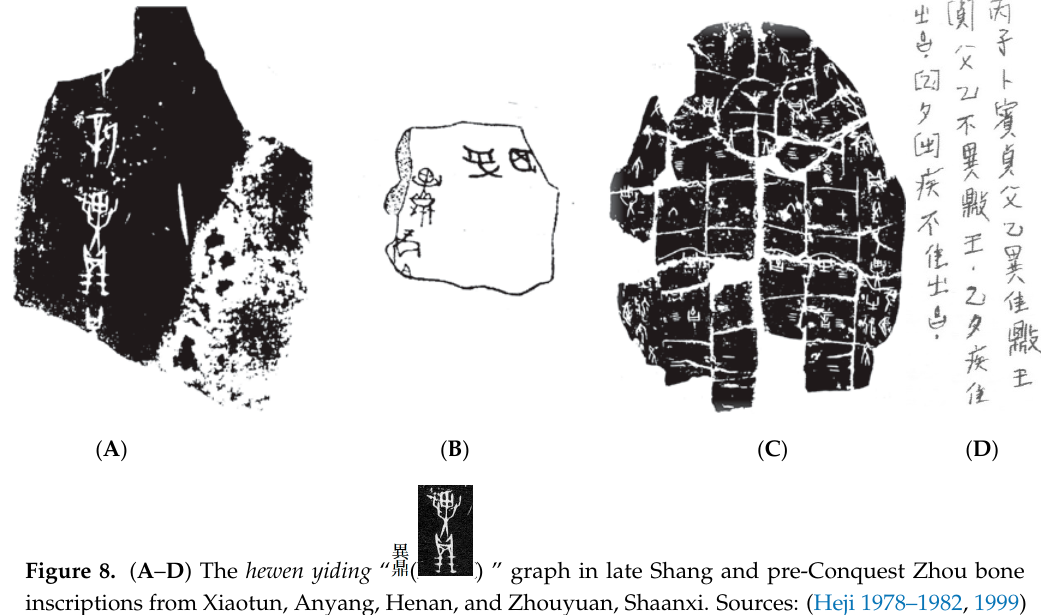
Figure 1. Masked semi-human figures with arms raised. ( A ) Yi 異 graph; ( B ) Displayed yi image, Childs-Johnson 2008 p. 8: Figure 8C, p. 58 (right). ( A ) […] 卜新 ( 異鼎 )), 祝 The bone was cracked: Childs-Johnson 2008, p. 8: Figure 8C, p. 58 (right). ( A ) [ . . . ] 卜 新 probably Kui; ( C ) Simplified displayed yi image.